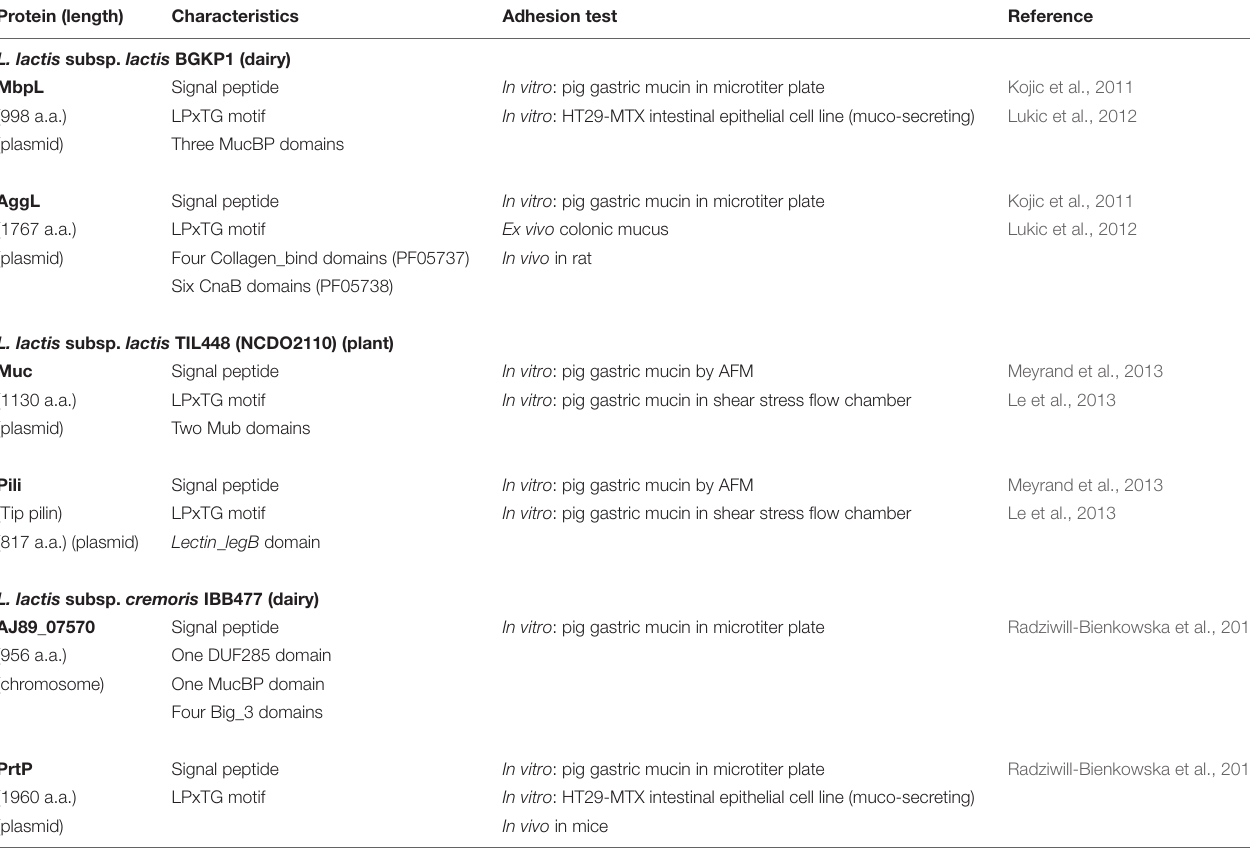
TABLE 1 | Surface proteins identified as responsible for muco-adhesive properties in different natural L. lactis strains and corresponding adhesion tests used to probe adhesion to mucus or mucins. Protein